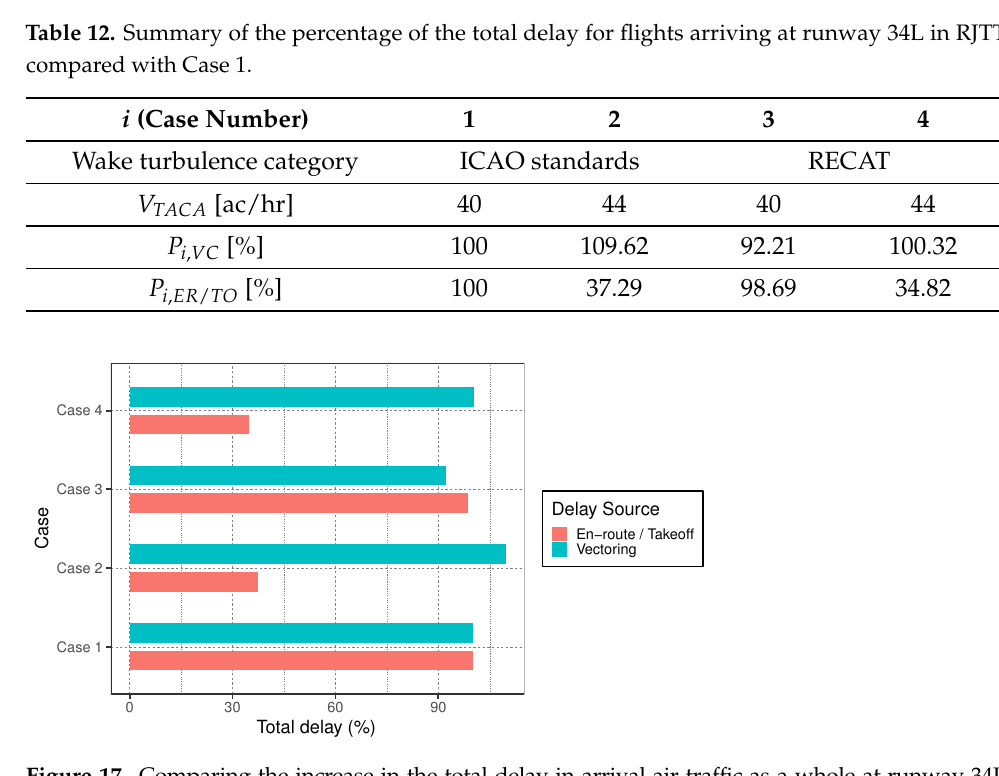
Figure 17. Comparing the increase in the total delay in arrival air traffic as a whole at runway 34L in